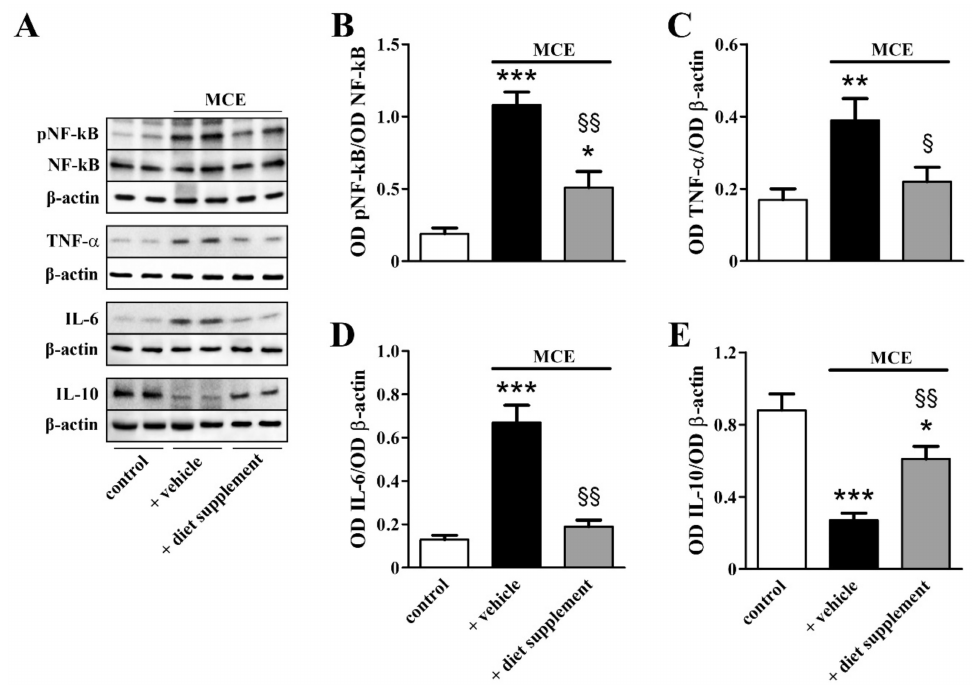
Figure 6. E ff ects of dietary supplementation on inflammatory markers. ( A ) Representative Western blots from retinal homogenates of control mice or mice that received MCE fed with either vehicle or diet supplement. ( B – E ) Densitometric analysis of the levels of phosphorylated form of nuclear factor kappa-light-chain-enhancer of activated B cells (NF-kB), tumor necrosis factor (TNF)- α , interleukin (IL)-6 and IL-10. MCE resulted in increased levels of the phosphorylated form of NF-kB, TNF- α and IL-6, while IL-10 levels were decreased, e ff ects that were almost completely prevented by dietary supplementation ( n = 6 for each group). * p < 0.05, ** p < 0.01 and *** p < 0.001 versus control; § p < 0.05 and §§ p < 0.001 versus MCE mice fed with vehicle (one-way ANOVA followed by the Newman–Keuls multiple comparison post-hoc test).